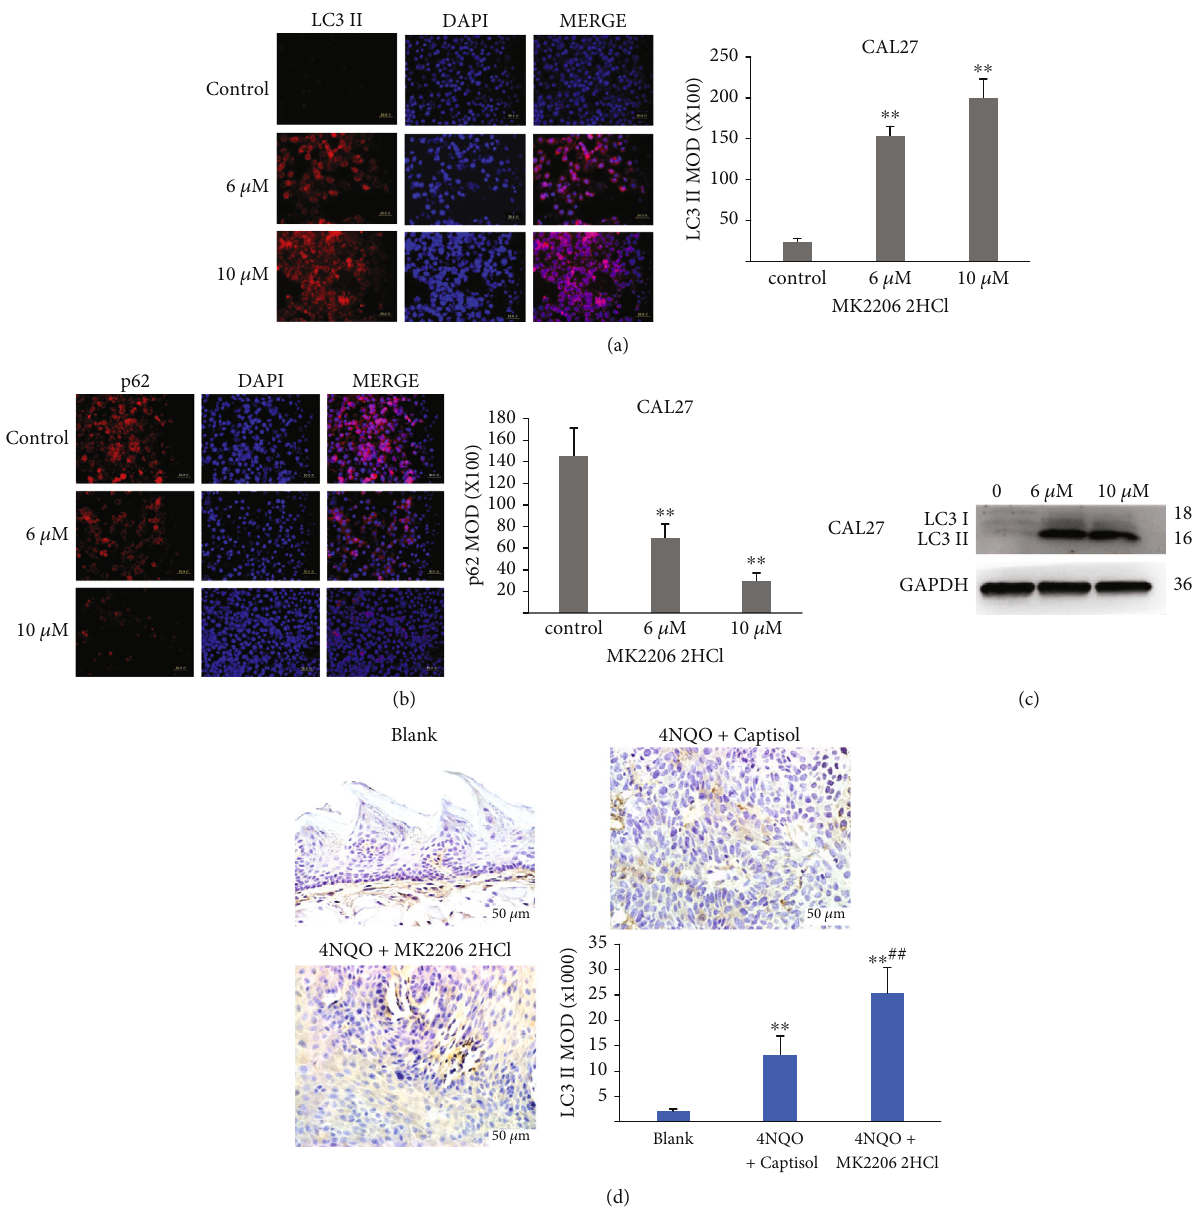
Figure 11: MK2206 2HCl induced LC3 II and p62 expressions in OSCC cells and 4NQO-induced mouse tongue tumors. (a) MK2206 2HCl promoted LC3 II expression in CAL27 cells as showed by immuno fl uorescence. Magni fi cation × 400. (b) MK2206 2HCl decreased